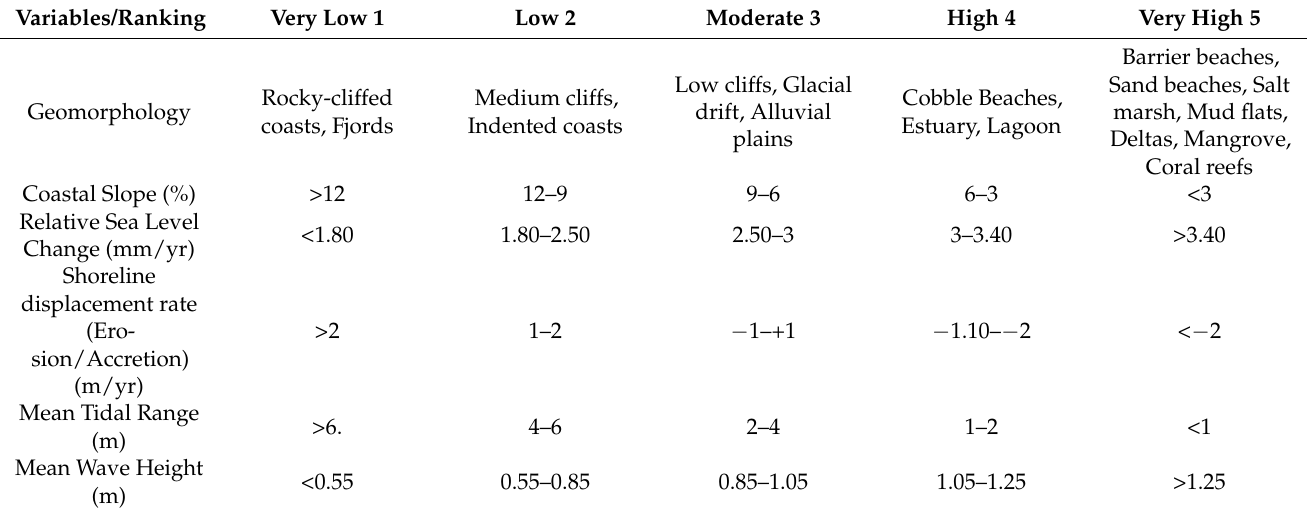
Table 1. Categorization of CVI variables according to Pendleton et al. (2004). A positive sign indicates shoreline advance, while a negative sign indicates retreat. For the coastal slope variable, the ranges proposed by Alexandrakis et al.,